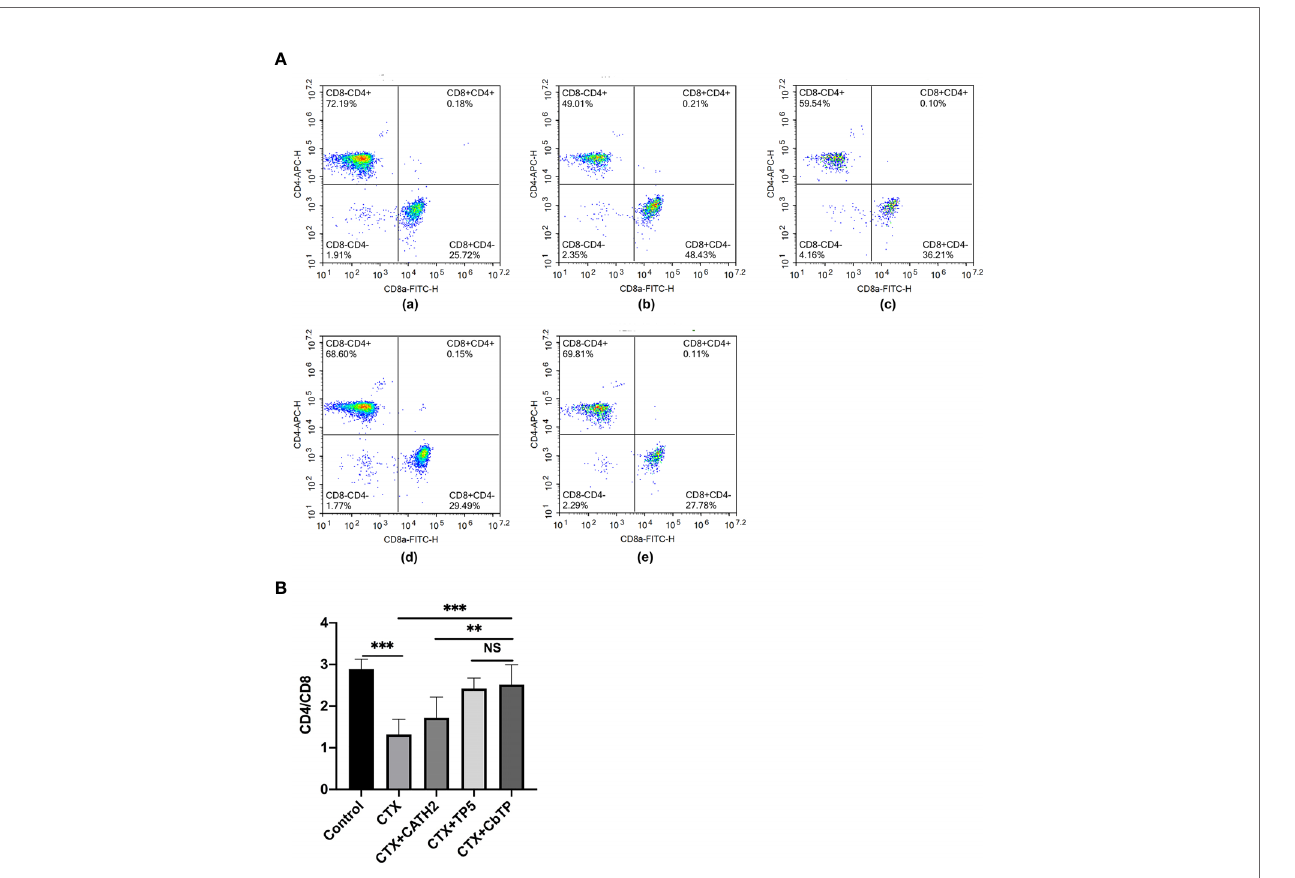
FIGURE 8 | Effects of CbTP on T lymphocyte subpopulations in splenocytes. The spleen was rinsed immediately with 40- m m mesh cell strainers fi lled with PBS to harvest cell suspensions after collection and grinding. The cells were stained using CD3-PerCP, CD4-APC and CD8-FITC for 30 min at 4°C for T lymphocyte measurements. (A) The percentage of different T cell subsets was analyzed by fl ow cytometry. (A-a) Control, (A-b) CTX, (A-c) CTX + CATH2, (A-d) CTX + TP5, (A-e) CTX + CbTP. Bivariate plots are shown as representative assessments, which were quanti fi ed and plotted as the ratio of CD4 + /CD8 + cells in part (B) . Statistical comparisons were performed by Student ’ s t test. The data are shown as the mean ± standard deviation (n=12). NS, p > 0.05; **p ≤ 0.01; and ***p ≤